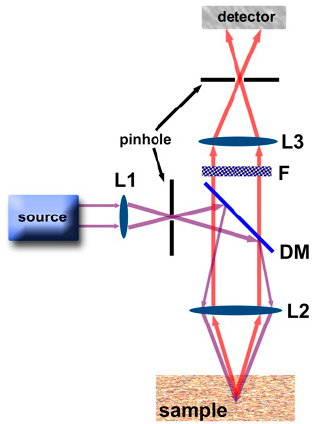
Figure 2. Confocal fluorescence microscope setup. L indicates lens, DM dichroic mirror, F filter, the purple and red lines indicate excitation and emission, respectively. Reproduced from [94] with permission from MDPI.